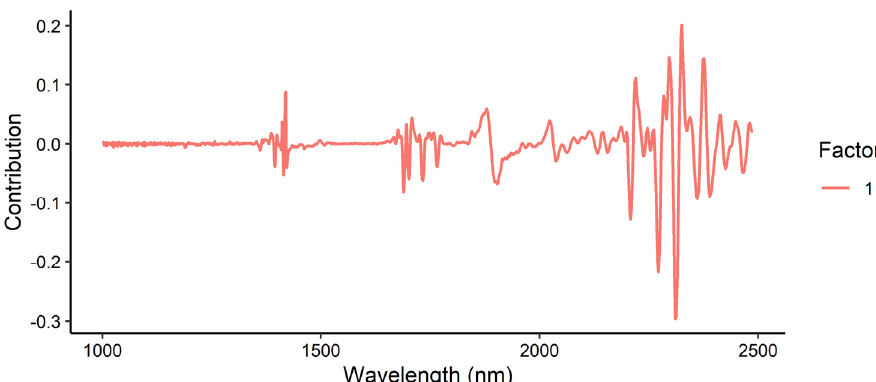
Figure 16. Loadings plot for the prediction of tebuthiuron content in Regain granules, using the benchtop Antaris NIR instrument.